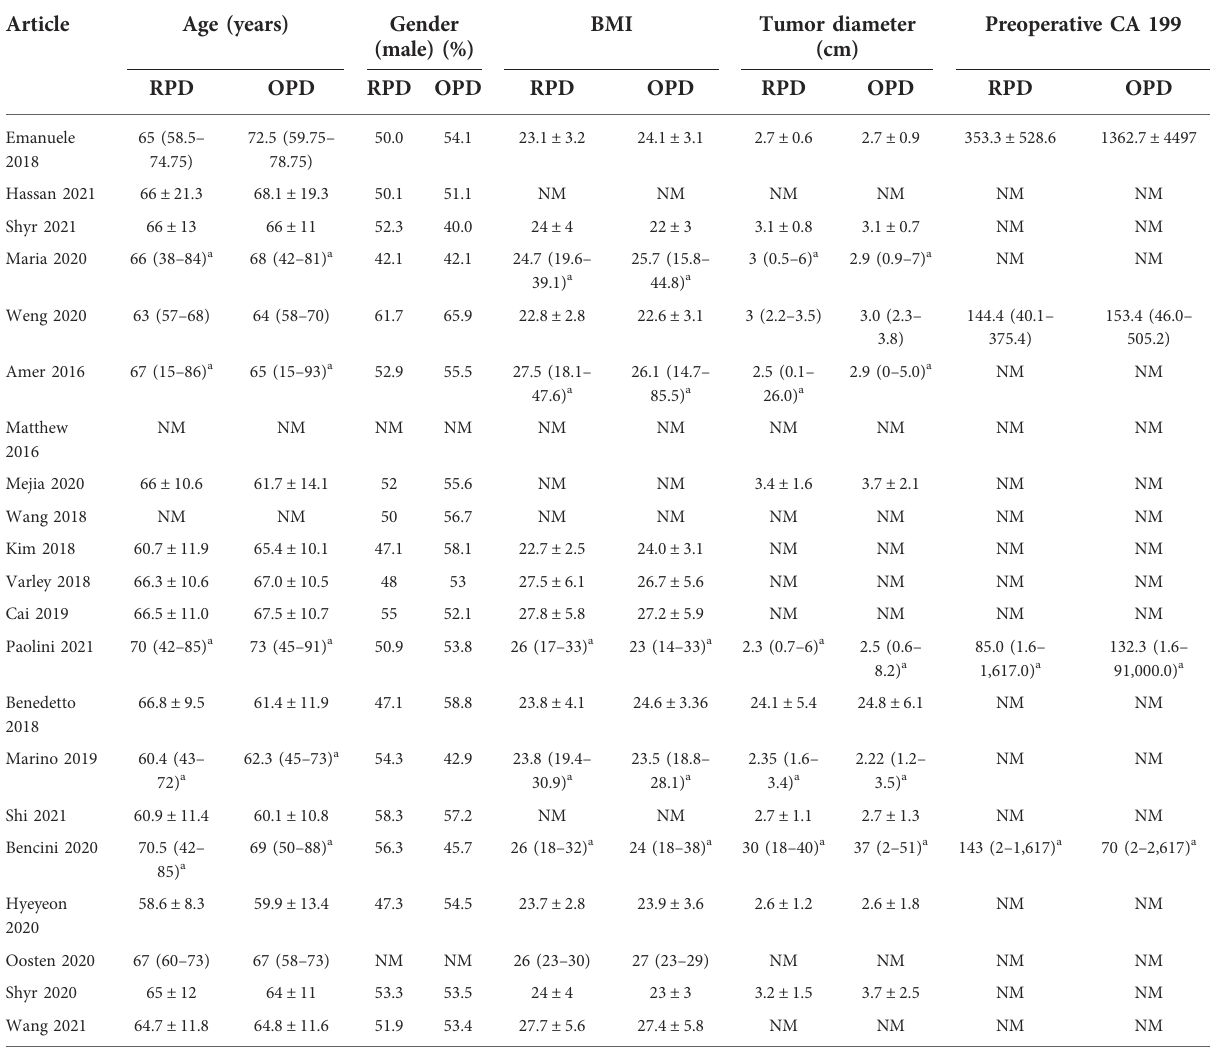
TABLE 2 Comparison of patients ’ baseline characteristics in robotic vs. open